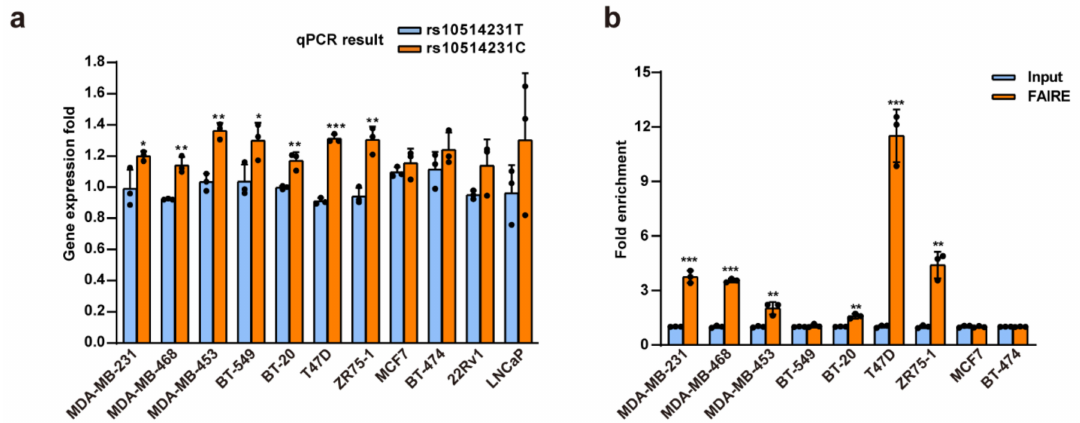
Figure 2. Rs10514231 shows enhancer activity in breast cancer cells. ( a ) The reporter expression level for each allele of rs10514231 was determined via RT-qPCR. MDA-MB-231, MDA-MB-468, MDA-MB-453, BT-549, and BT-20 were classified as triple-negative breast cancer (TNBC) cell lines. T47D, ZR75-1, and MCF7 were LumA cell lines. BT-474 was LumB and also Her2+ cell lines. Values are the means ± SD; * p < 0.05, ** p < 0.01, and *** p < 0.001, two-tailed Student’s t test. ( b ) Chromatin open status of the rs10514231 region in breast cancer cells, detected by FAIRE-qPCR. Values are the means ± SD; * p < 0.05, ** p < 0.01, and *** p < 0.001, two-tailed Student’s t